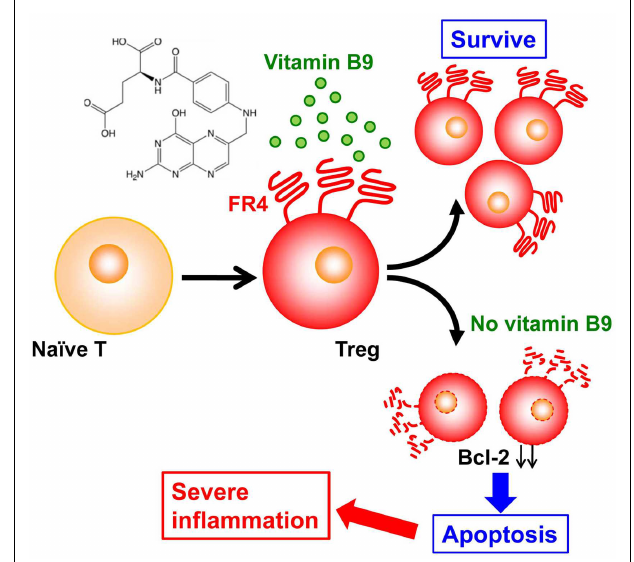
FIGURE 2 |Vitamin B9 is required for the survival of regulatoryT cells and subsequent maintenance of immunologic homeostasis in the intestine . Once naïveT cells differentiate into regulatoryT (T reg ) cells, they express folate receptor 4 (FR4), and require vitamin B9 for their survival. The absence of sufficient amounts of vitamin B9 induces the apoptosis of T reg cells, with decreased expression of Bcl-2 and subsequent increased intestinal